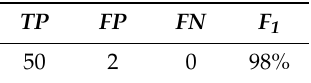
Table 2. True positive, false positive and false negative rate of the classification system on the test set and a combined F 1 score for the three rates.